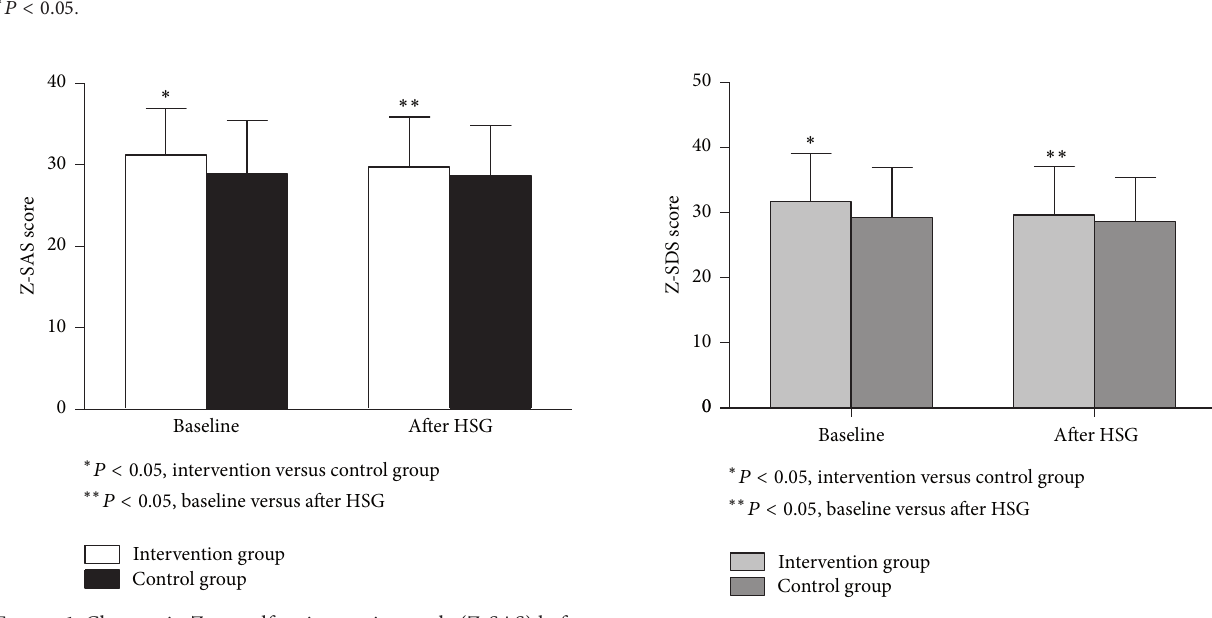
Figure 1: Changes in Zung self-rating anxiety scale (Z-SAS) before and after hysterosalpingography (HSG) in the intervention and the control groups. Scores above 36 identify clinically significant anxiety.